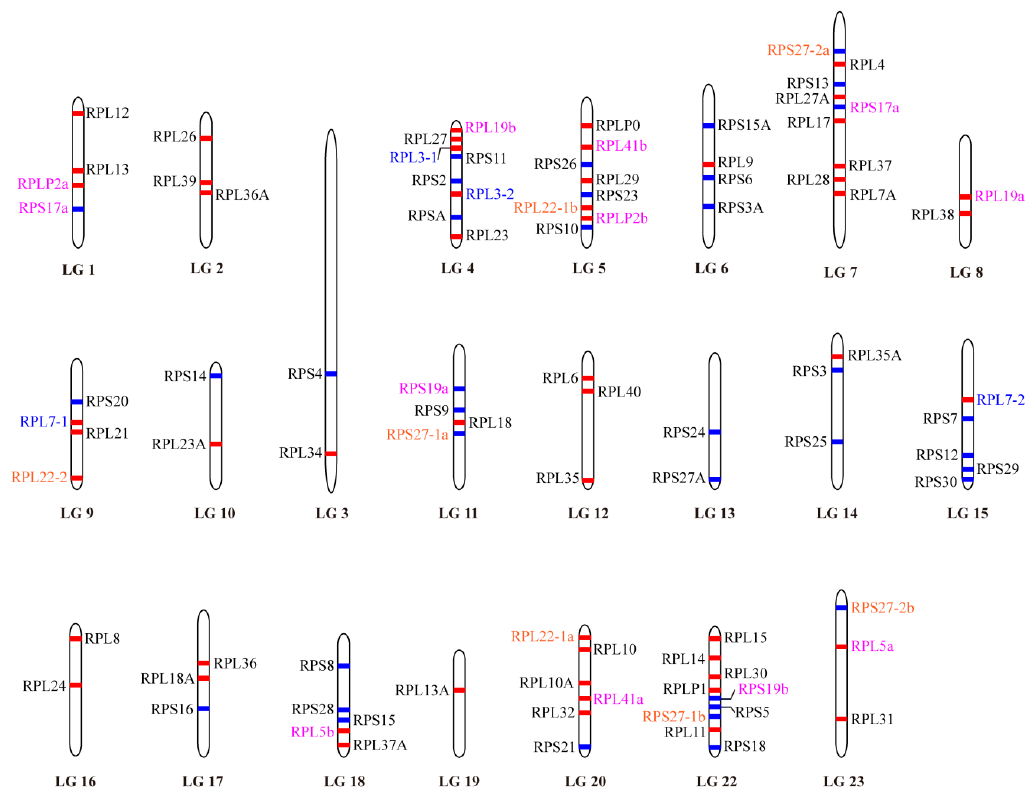
Figure 1. Chromosomal maps of the RP genes in Nile tilapia. RP genes are depicted on a linkage group (LG) of the genome (Release 2). LG21 is absent because it has been combined withLG16. Red and blue horizontal lines indicate the large subunit and small subunit RP genes, respectively. Gene name in blue indicates genes derived from 2R event. Gene name in magenta indicates genes derived from 3R event. Gene name in orange indicates genes derived from both 2R and 3R events.